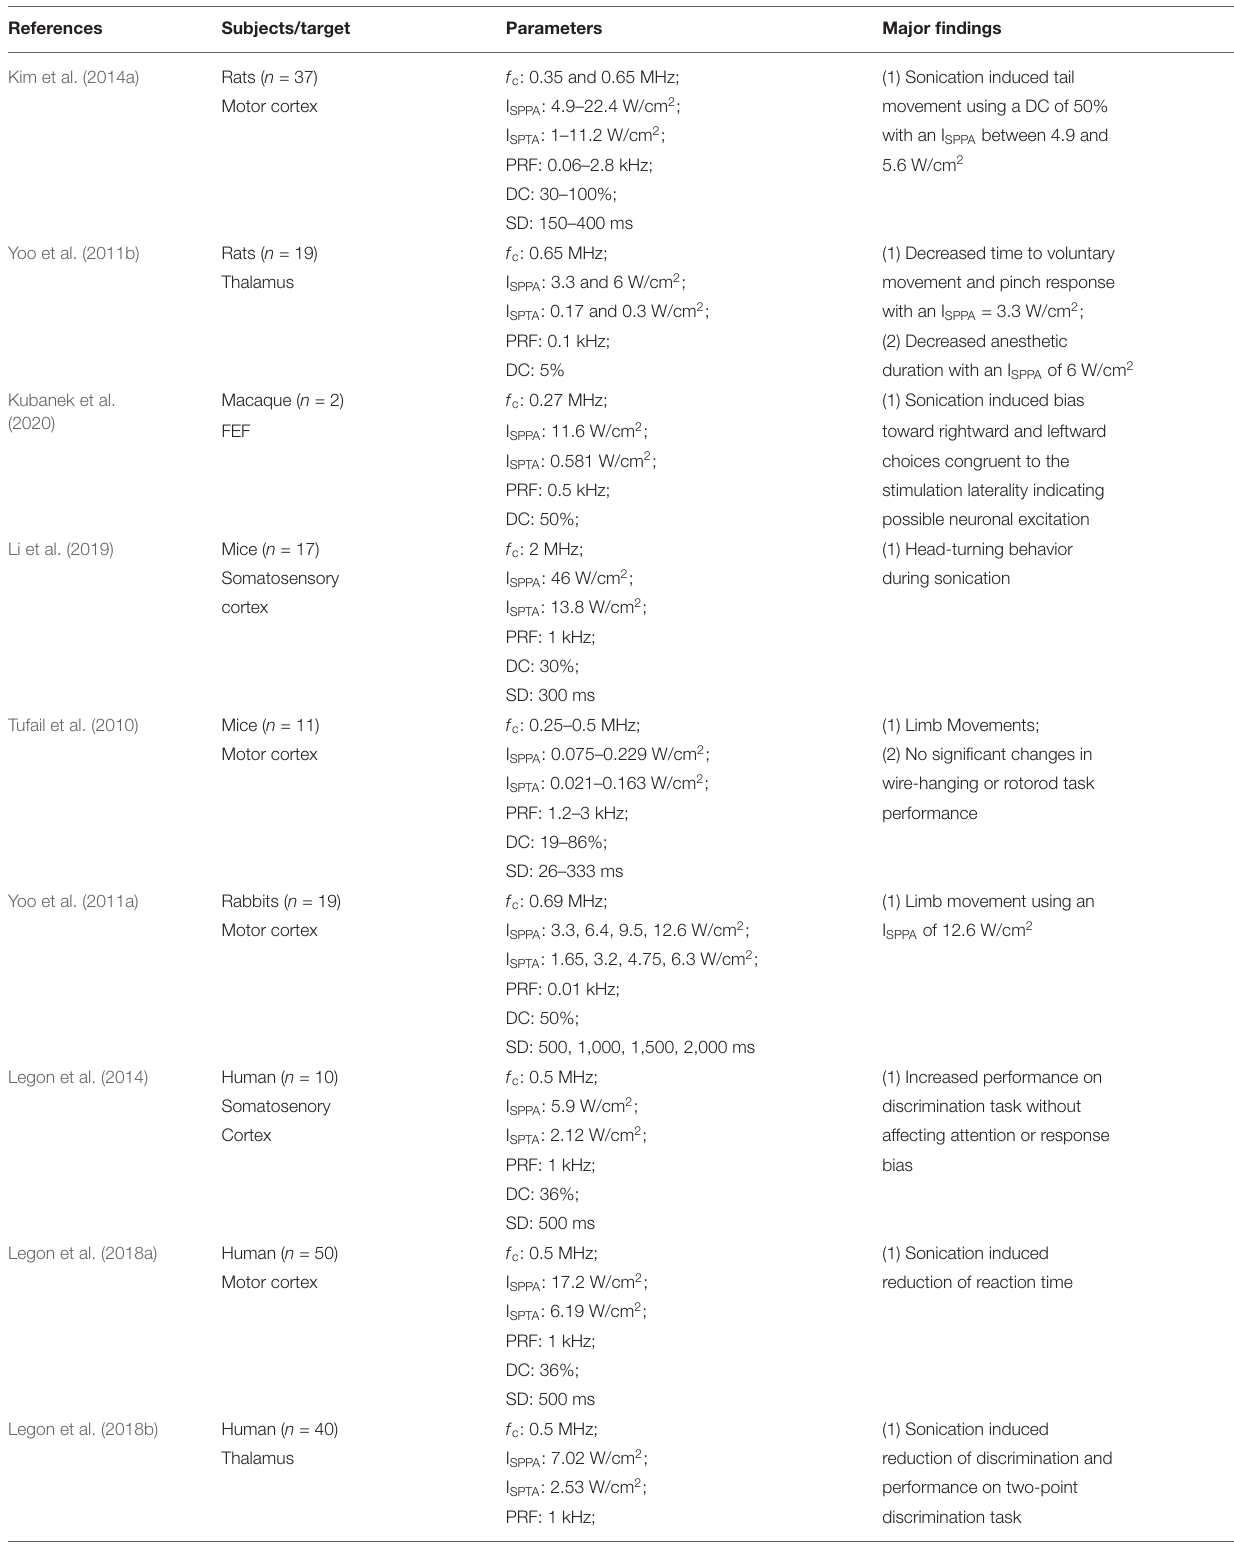
TABLE 3 | Behavioral findings for animals and